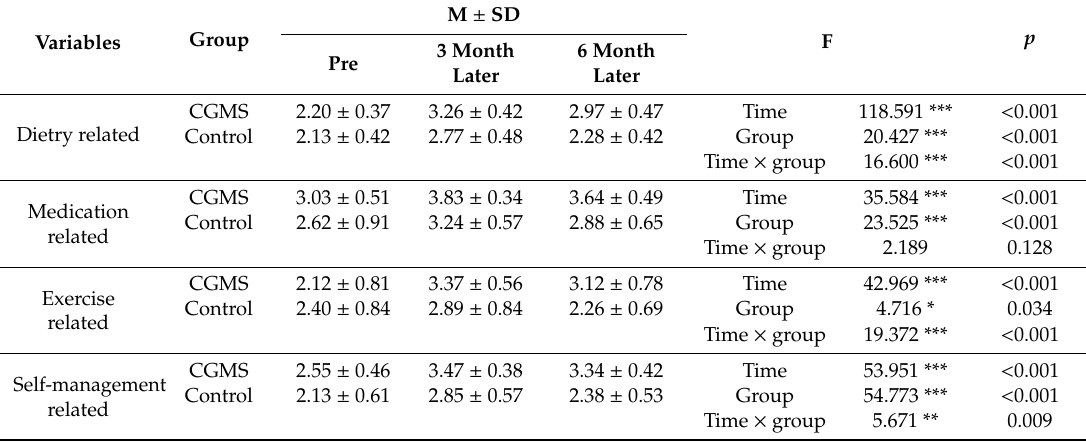
Table 3. Difference of self-care behavior factors according to group. Table 3. Di ff erence of self-care behavior factors according to